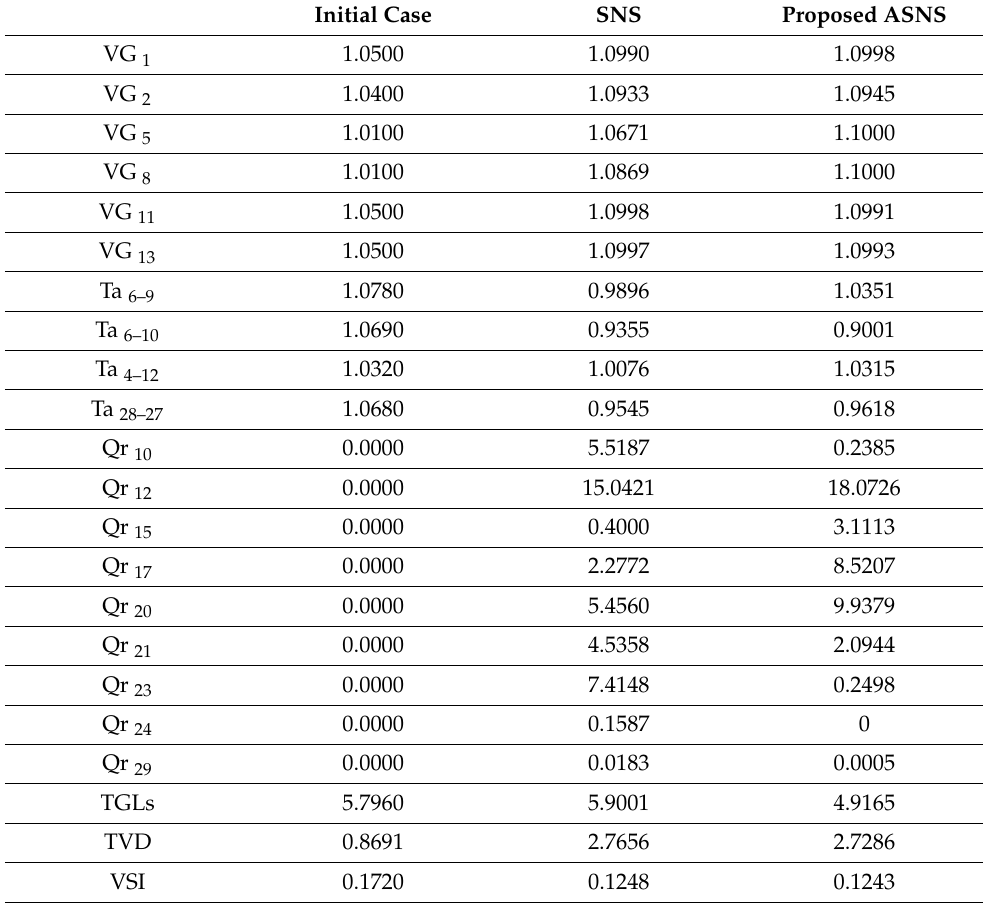
Table 4. Optimal results for Case 3 of the IEEE 30-bus grid.